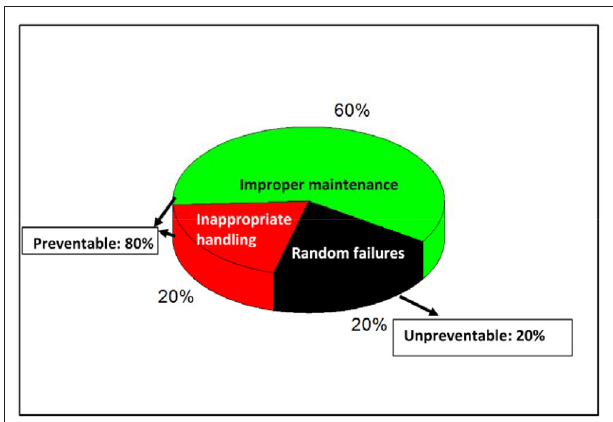
FIGURE 2 | Biomedical equipment